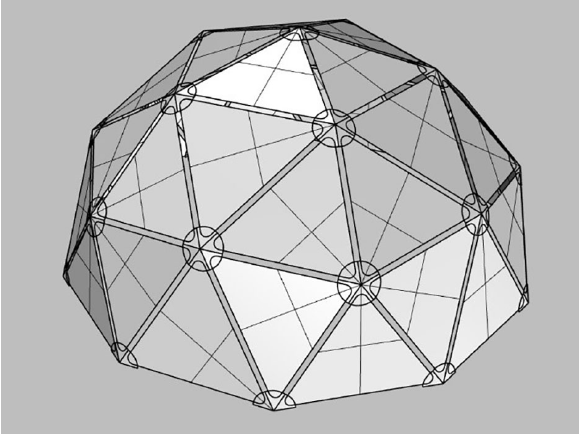
Figure 9: 3D model of a geodesic dome using parametric